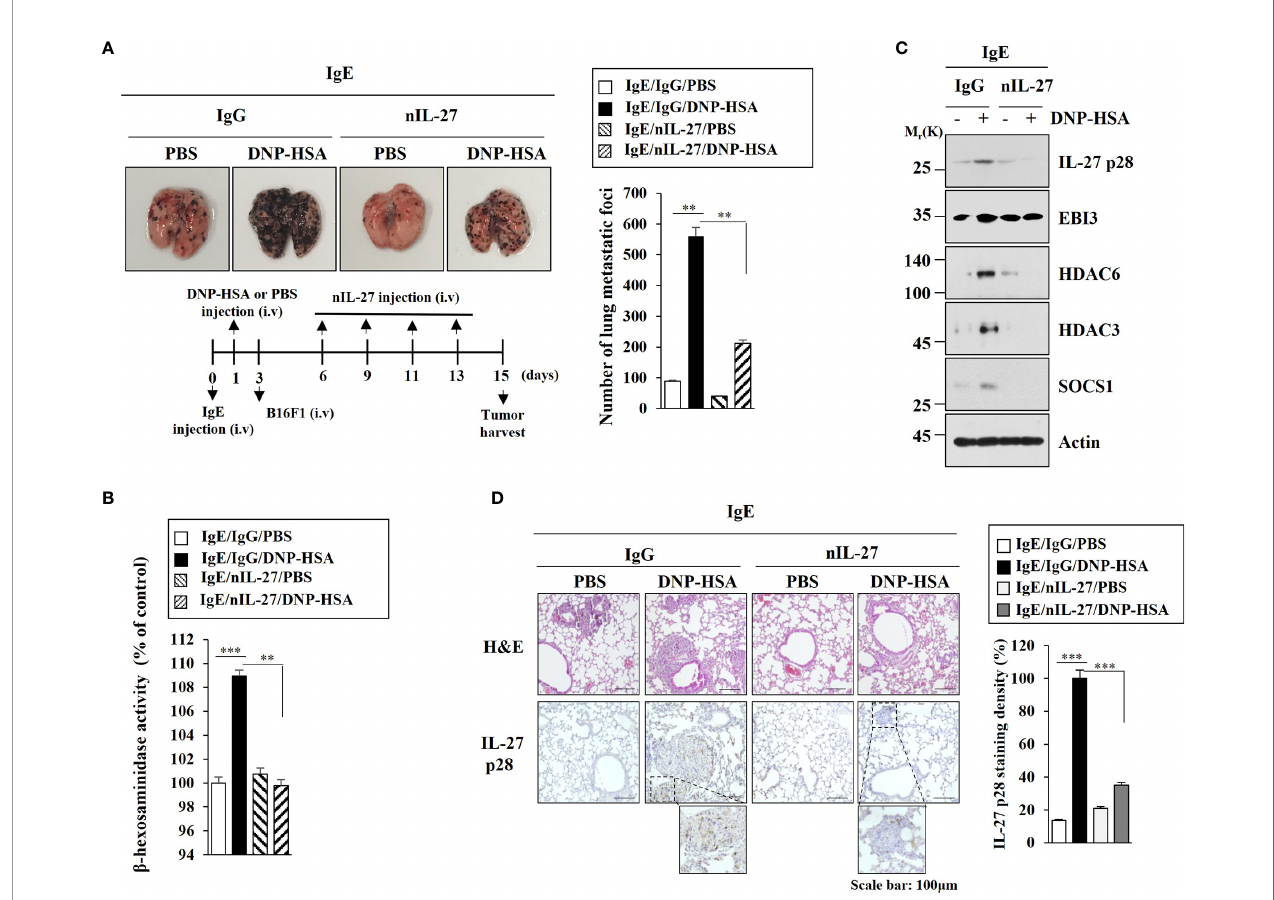
FIGURE 8 | IL-27 is necessary for enhanced metastatic potential by PSA. (A) Each mouse was injected with B16F1 melanoma cells (2 × 10 5 ) on day 3. The extent of lung metastasis was determined. ** p <0.01. (B) The b -hexosaminidase activity assays employing lung tumor tissue lysates were performed (n=4). ** p <0.01; *** p <0.001. Average values of three independent experiments are shown. (C) Immunoblot employing tumor lysates was performed (n=4). Representative blots of three independent experiments are shown. (D) Lung tumor tissues were subjected to H&E staining and Immunohistochemical staining. Representative images of the staining are shown (n=3). Quanti fi cation was performed using Image J (NIH). *** p